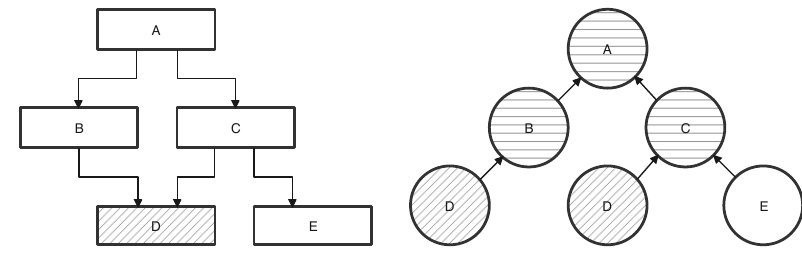
Figure 7. CFG to